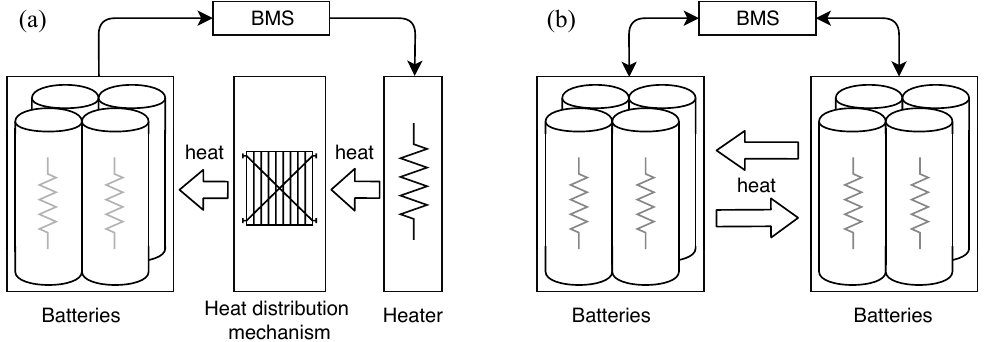
Figure 1. ( a ) External heating model. ( b ) Mutual pulse heating